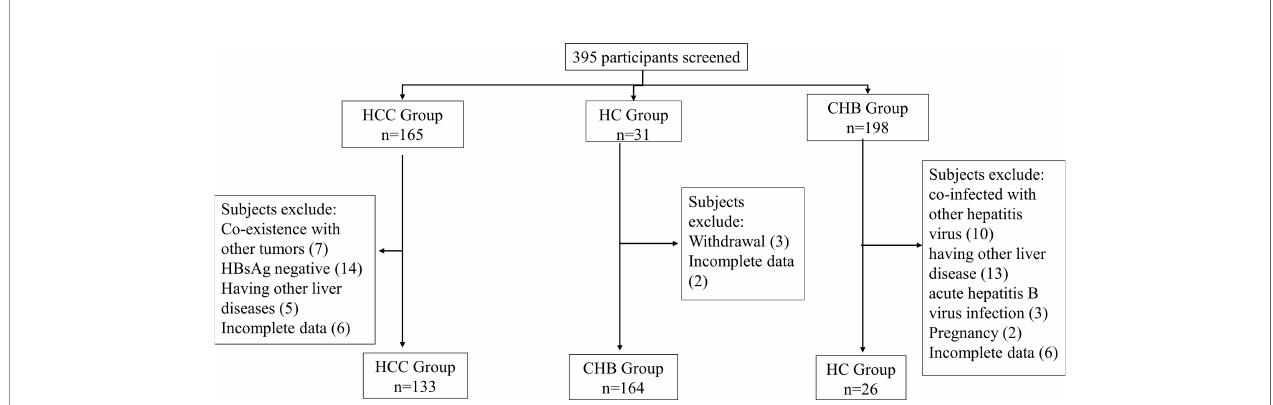
FIGURE 1 | Patient selection